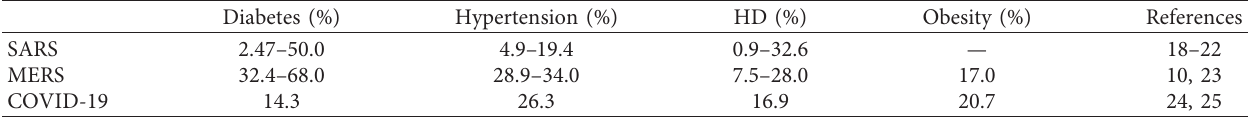
Table 1: Influence of comorbidities in coronaviruses infections, SARS-CoV, MERS-CoV, and SARS-CoV-2 outbreaks. Diabetes